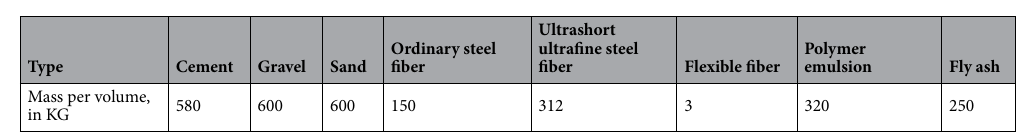
Table 2. Masses of materials per cubic